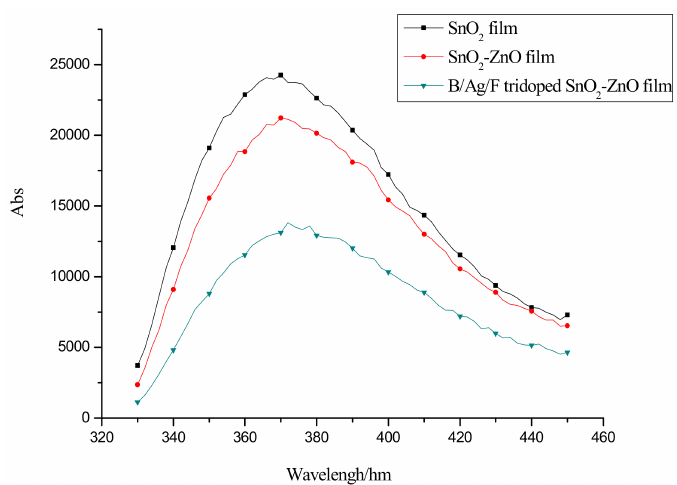
Figure 5. Photoluminescence (PL) spectra of pure SnO 2 , SnO 2 -ZnO, and B/Ag/F tridoped SnO 2 -ZnO films.